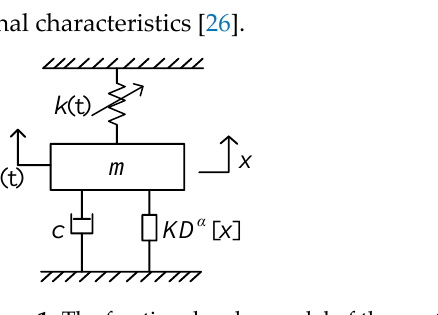
Figure 1. The fractional-order model of the pantograph – catenary system.